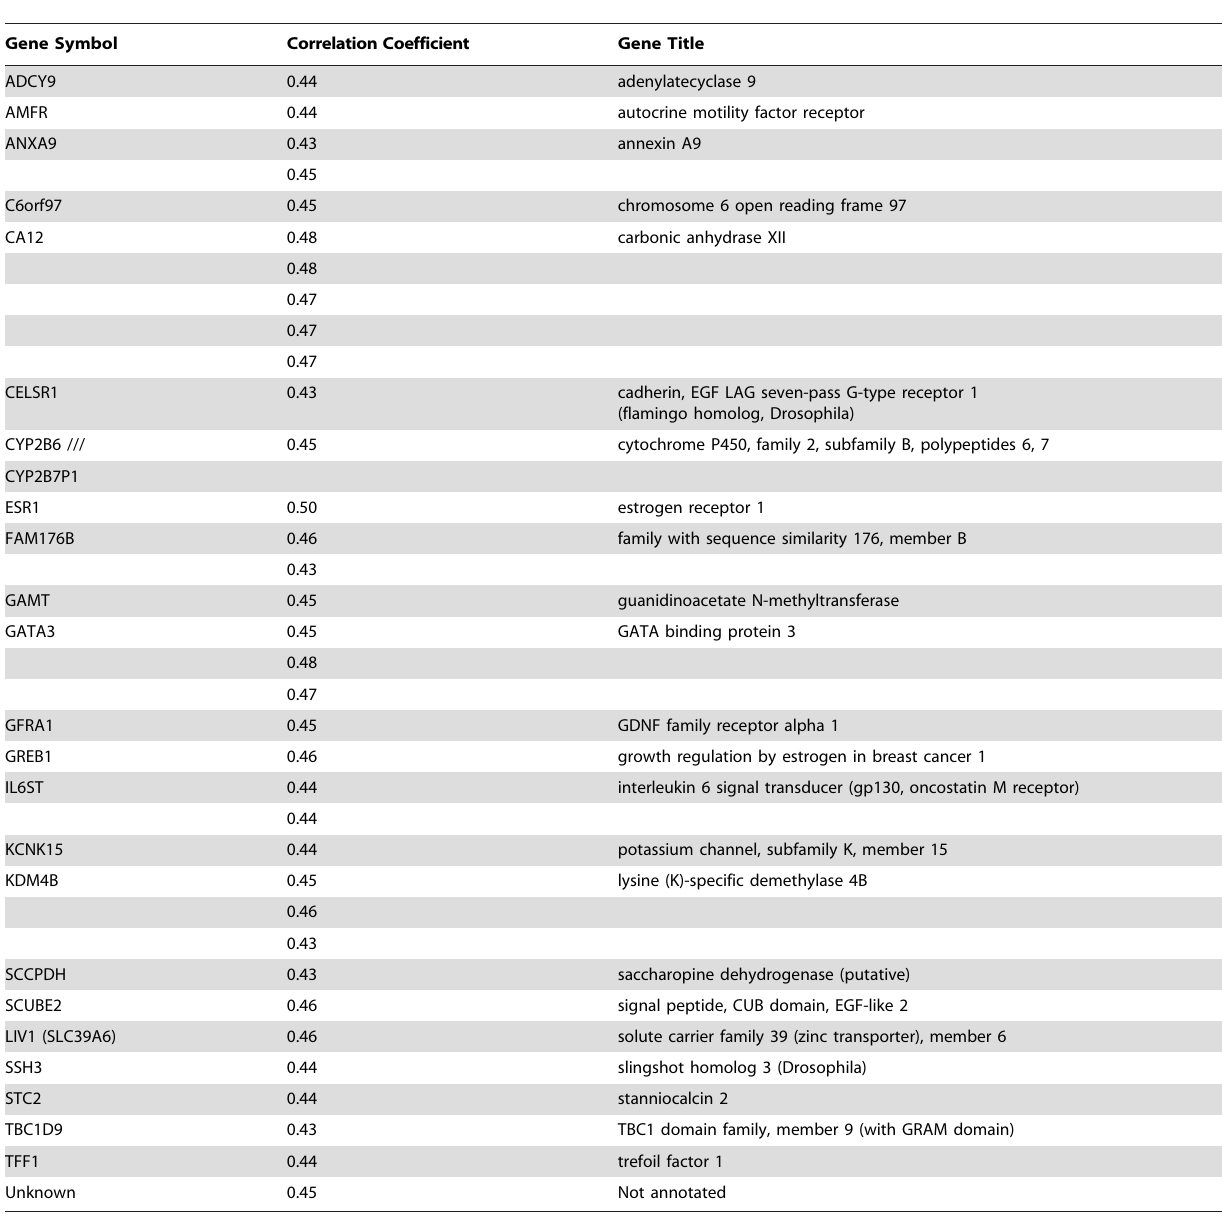
Table 1. Gene signature predictive of ER status.